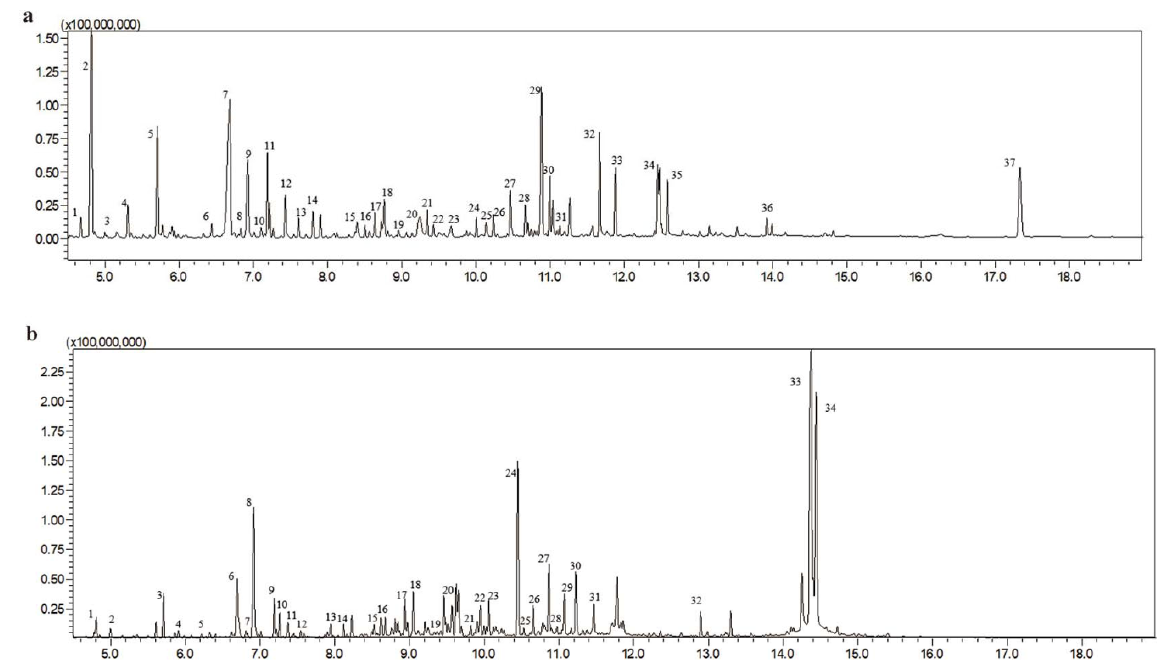
Figure 2. Representative total ion current chromatograms in serum and urine. ( a ) Typical com- pounds in serum as follows: 1. Pyruvate; 2. Lactate; 3. Glycolic acid; 4. Alanine; 5. Oxalic acid; 6.